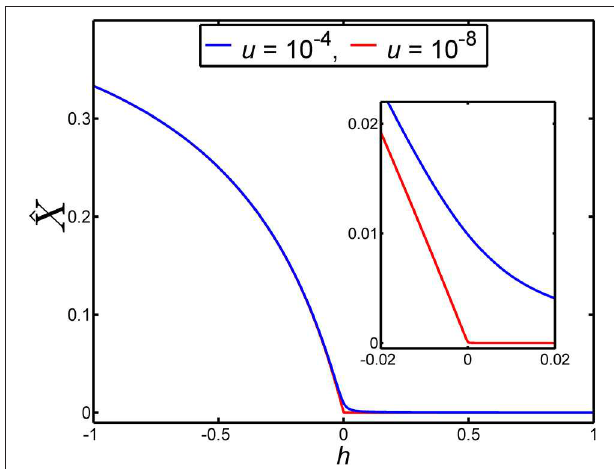
FIGURE 2 | The equilibrium frequency of a lethal allele in a very large population, ˆ X , depends on the dominance coefficient, h , according to Equation (9). In this figure the dependence of ˆ X on h is illustrated for two different values of the mutation rate, u . The blue curve gives the dependence of ˆ X on h when the mutation rate is u 10 − 4 . The red curve gives the dependence of ˆ X on h = when the mutation rate is u 10 − 8 . The inset is an enlargement of main panel = h over the range 0.02 0.02, to show the detailed behavior of ˆ X over this − ≤ ≤ small range of h . We note that the larger mutation rate ( u 10 − 4 ) was chosen = for the purposes of visualization rather than